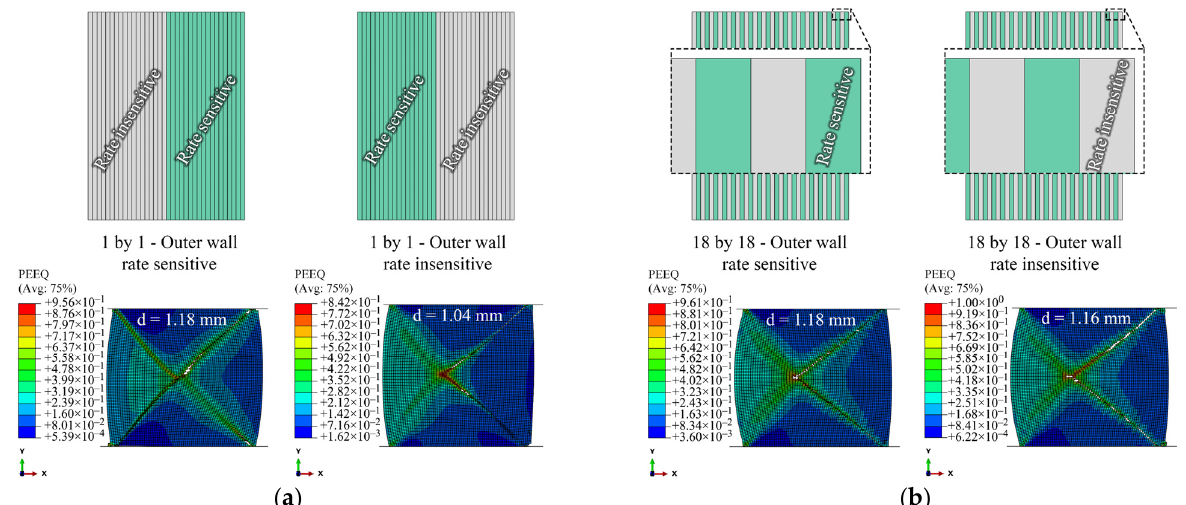
Figure 7. Effect of cladding on f–d curves.